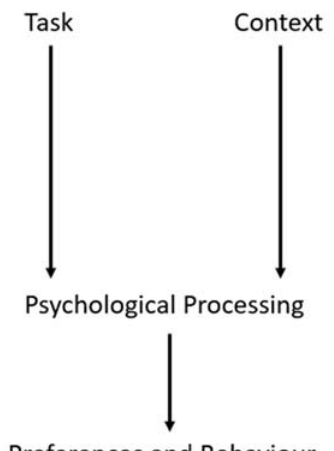
Figure 1. Construction of preferences ‘on the fly’.